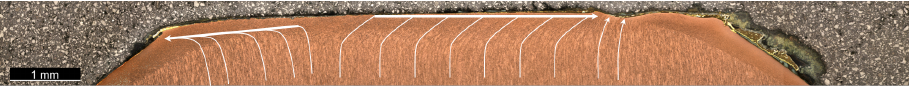
Figure 14. Mushrooming due to radial material flow indicated by white arrows of upper electrode of MC01–TS01 after 1200 spot welds in